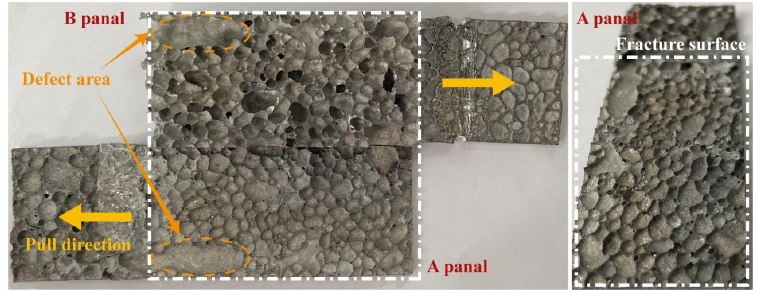
Figure 11. Series images of the panel peeling teat of metallurgical bonded AFS: ( a ) 0 mm, ( b ) 0.8 mm, ( c ) 1.6 mm, ( d ) 2.4 mm, ( e ) 4.0 mm, ( f ) 5.1 mm;